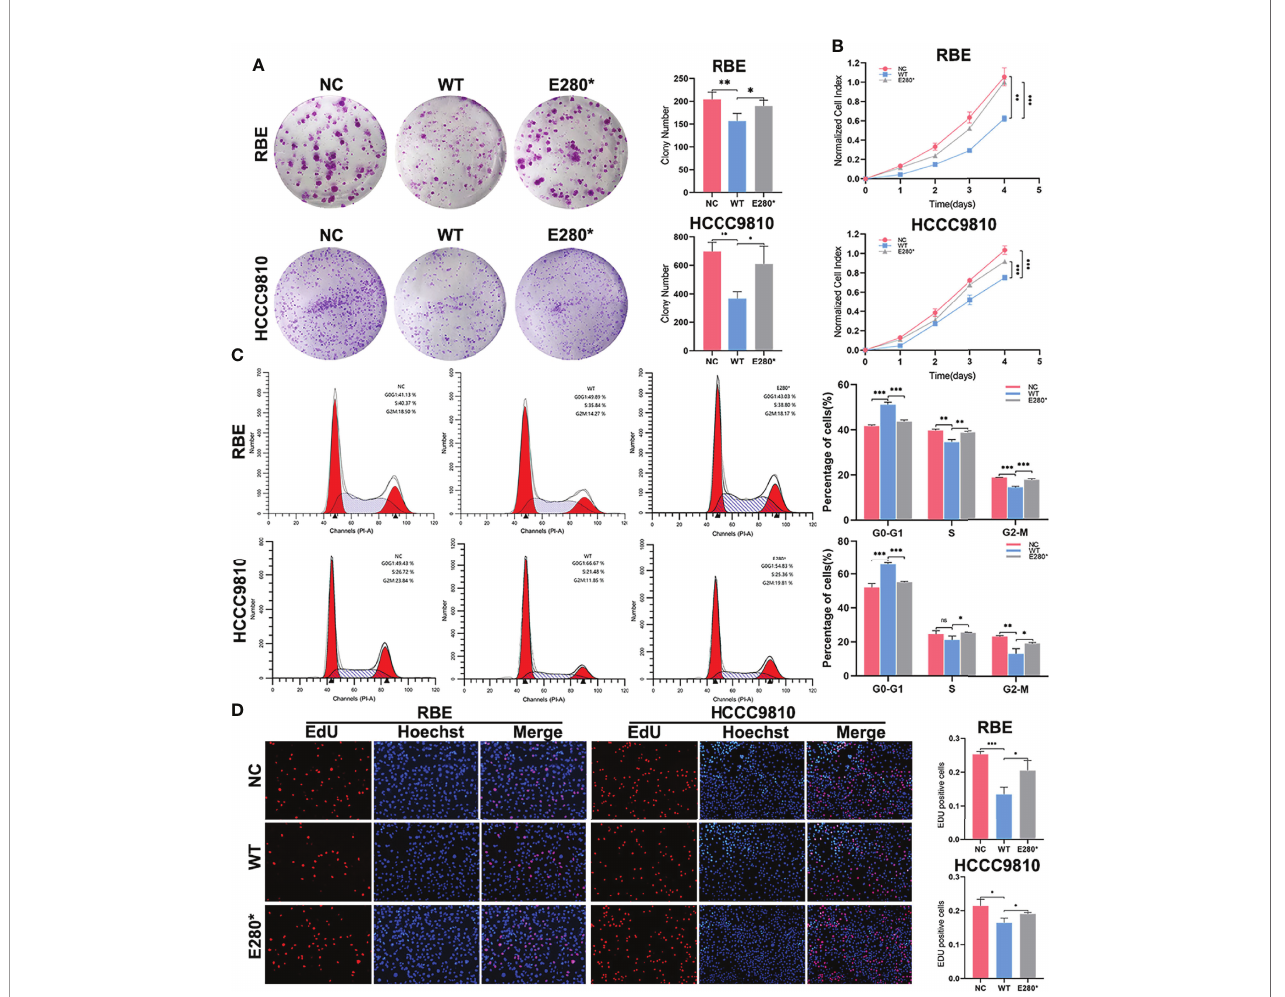
FIGURE 2 | ROBO1 E280 * repressed the tumor-suppressing effects of ROBO1 WT on proliferation in cholangiocarcinoma (CCA) cells. (A) The clone formation ability of CCA cells was impaired by ROBO1 WT and rescued by ROBO1 E280 *. (B) The overexpression of ROBO1 WT reduced the proliferation rate of CCA cells, which was reversed by the overexpression of ROBO1 E280 *. (C) Flow cytometry analysis of the cell cycle of CCA cells transfected with LV-ROBO1 WT , LV-ROBO1 E280 *, and LV-NC. (D) ROBO1 E280 * reversed the descending trend of EdU-positive cells in the ROBO1 WT group. *P < 0.05, **P < 0.01, ***P <